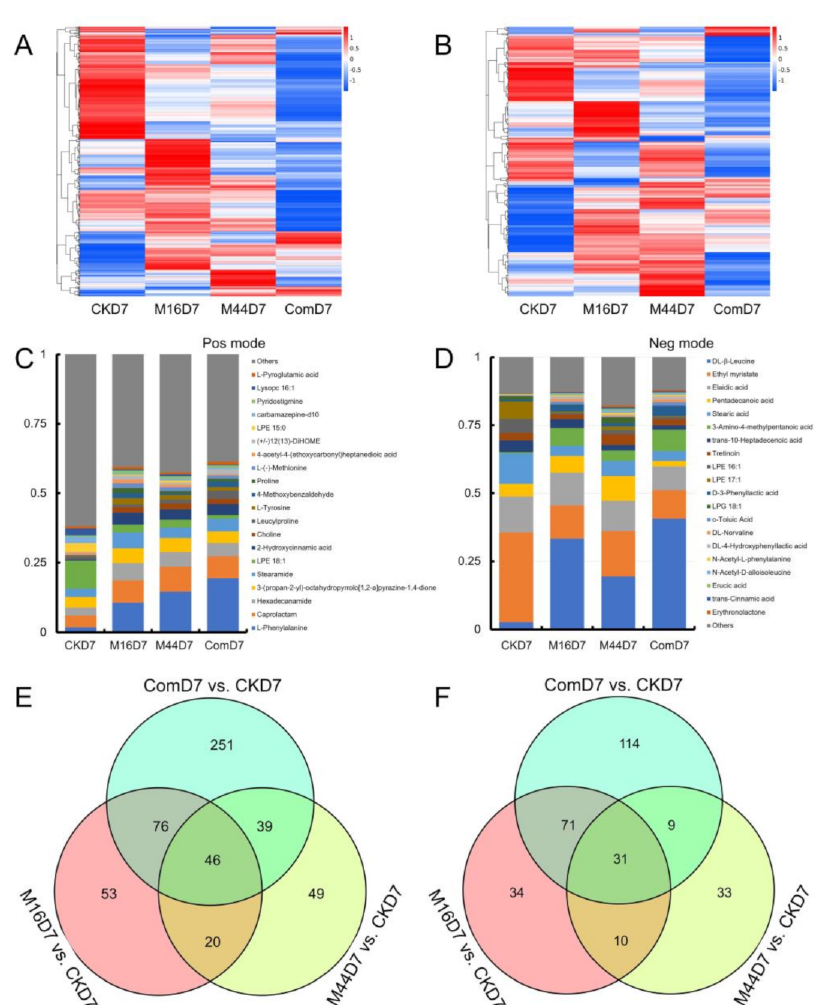
Figure 2. Metabolomic composition and structural variation with different treatments. ( A ) Heatmap of all metabolites detected from different treatments in the positive-ionization mode. ( B ) Heatmap of all metabolites detected from different treatments in the negative-ionization mode. ( C ) Relative abundance of top 20 metabolites from all treatments in the positive-ionization mode. ( D ) Relative abundance of top 20 metabolites from all treatments in the negative-ionization mode. ( E ) Venn diagram showing the differential metabolites among group comparisons in the positive-ionization mode. ( F ) Venn diagram showing the differential metabolites among group comparisons in the negative-ionization mode. CK: control; M16: M16 treatment; M44: M44 treatment; Com: combination of M16 and M44; D7: day